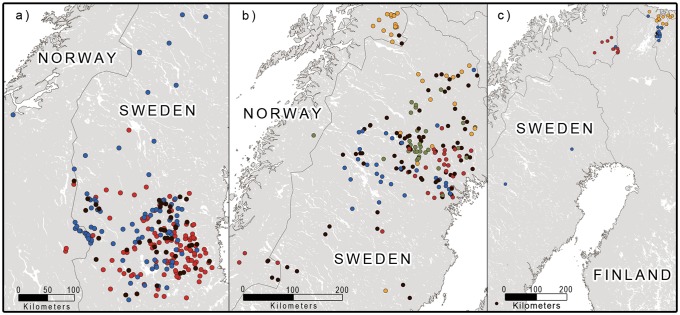
Location of female brown bears belonging to the different genetic subclusters in Scandinavia, determined by the reanalysis of each previously determined cluster.Individuals whose membership could not be determined (q < 0.7) are colored black. a) Subclusters within cluster 1, b) subclusters within cluster 3, c) subclusters within cluster 4. Note that the colors used to depict subcluster membership do not correspond to the color coding used in the other maps.